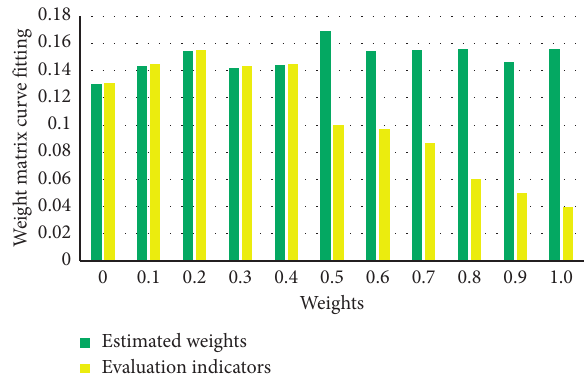
Figure 8: The weight matrix curve fitting diagram of the regression analysis of the evaluation index